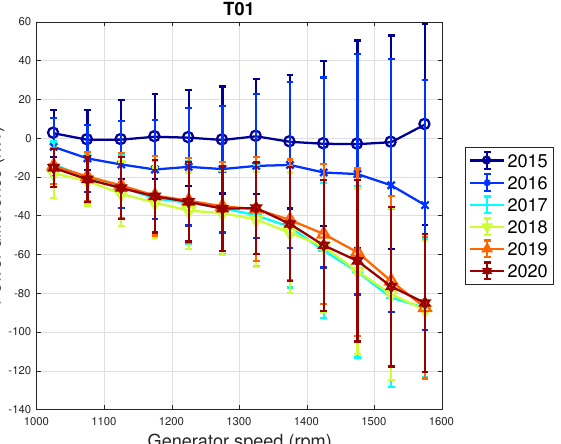
Figure 9. Binned generator speed–power curve in Region 2 for T01 in WF2: the curves are reported in the form of difference with respect to the year 2014.